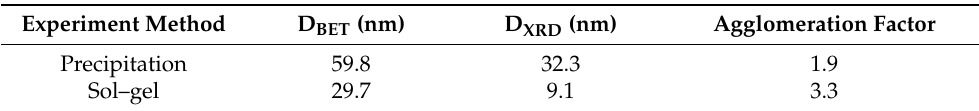
Table 1. Characterization of the Gd 2 O 3 -MgO nanocomposite powders synthesized from differ- ent